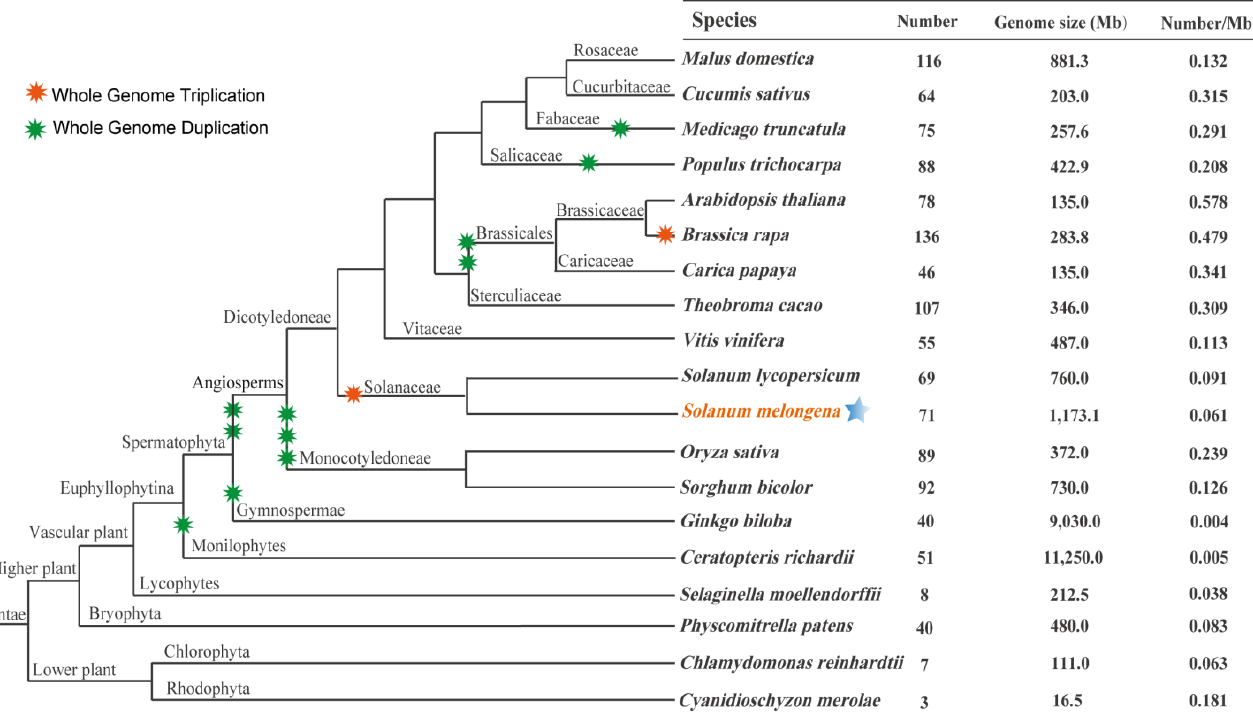
Figure 3. Summary of bZIP genes family among 19 genomes of different plant species.